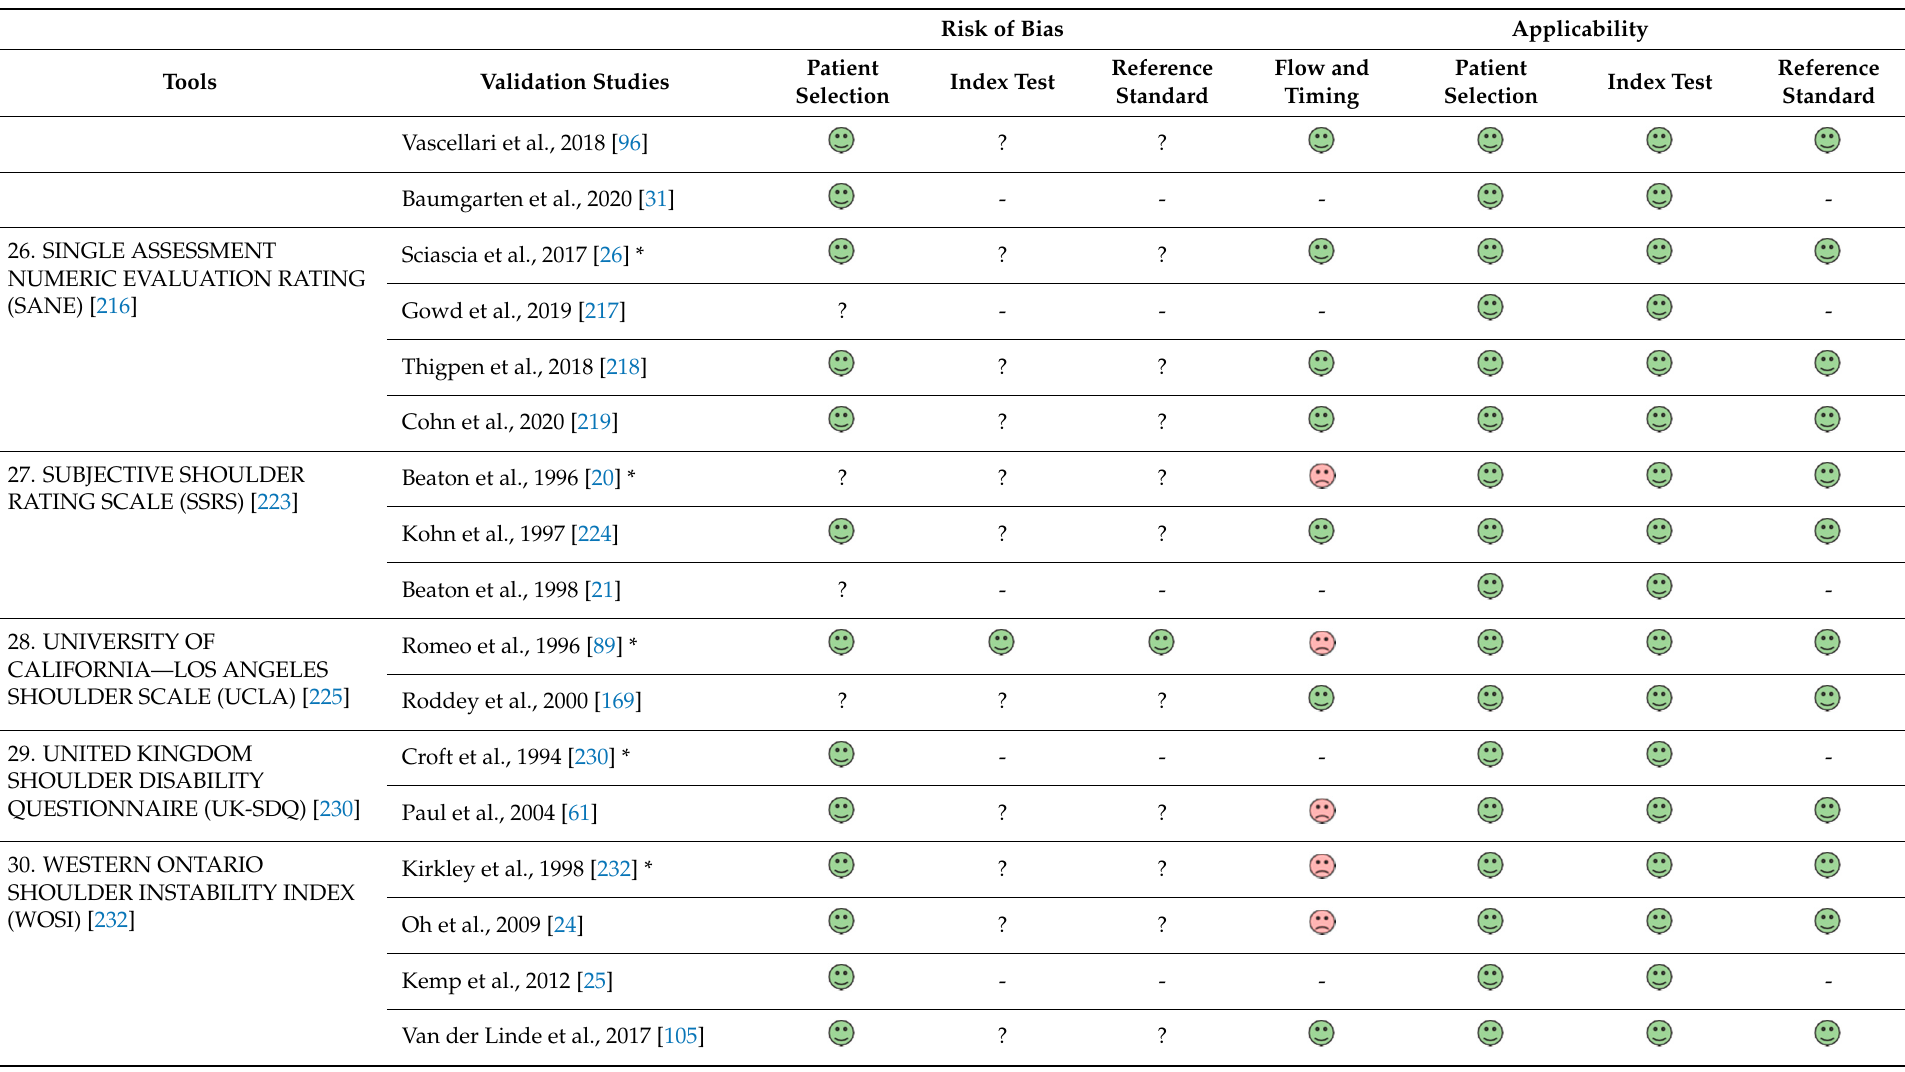
Table 3. Assessment of the methodological quality with QUADAS ‐ 2.